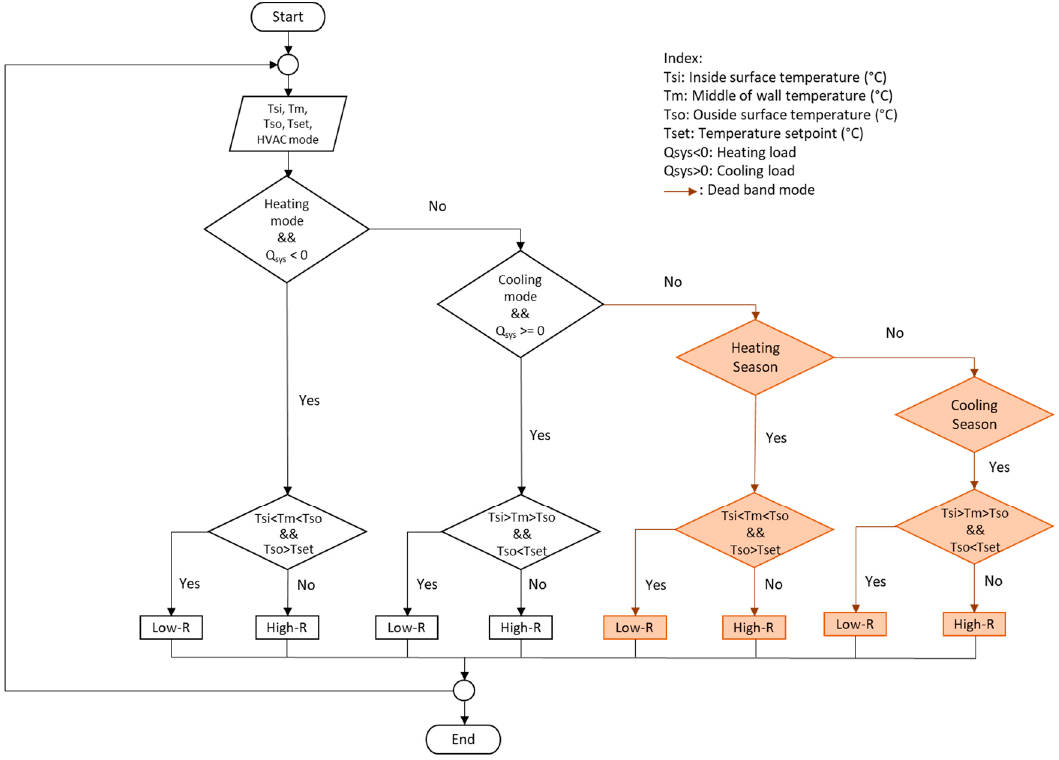
Figure 3. Simple rule set used in this study for SIS-equipped walls. Table 1. Characteristics of the modeled apartment and detached house.